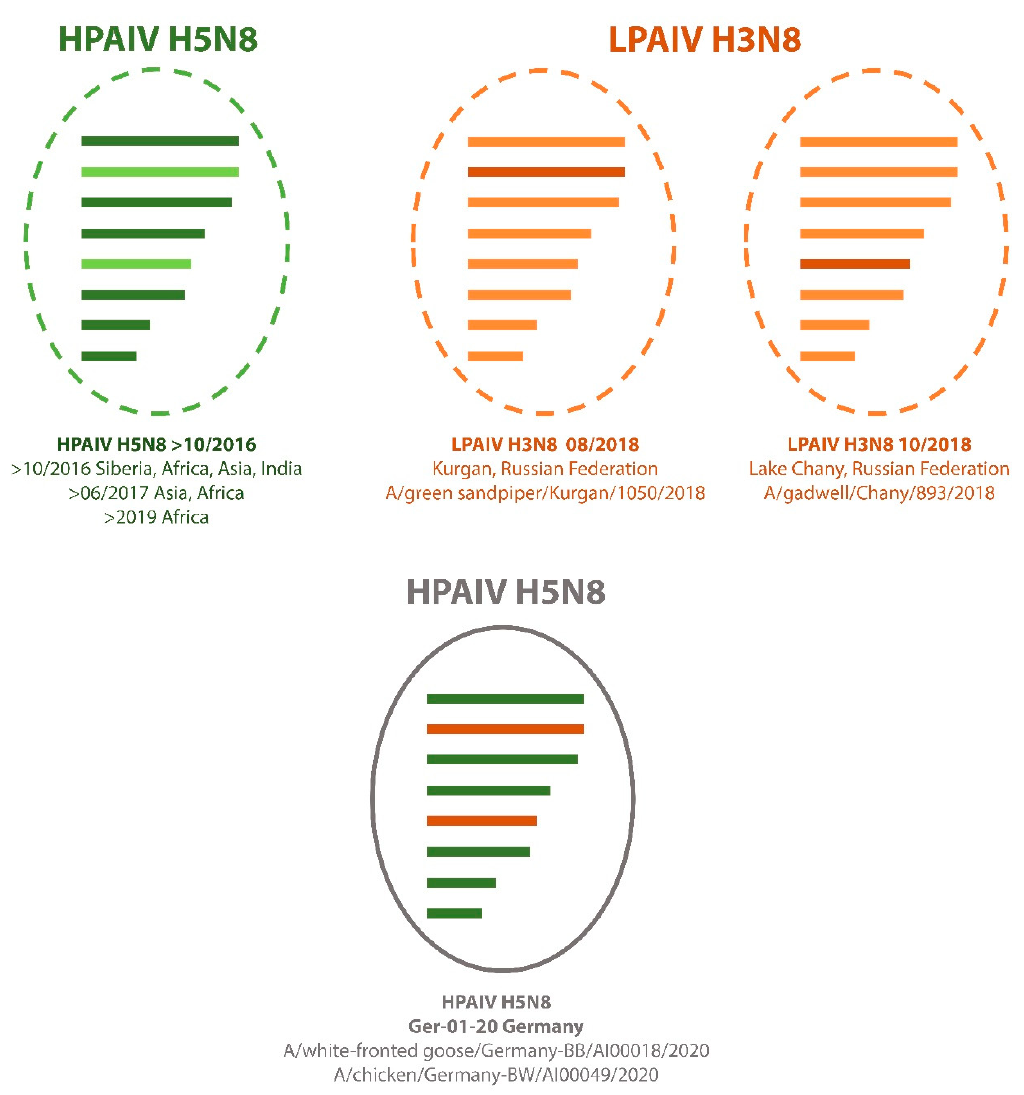
Figure 3. Schematic reassortment analyses based on full-length sequences from AIVs previously detected (upper panel) and the novel HPAIV H5N8 reassortant Ger-01-20 (lower panel). Colors are allocated according to reassortment and display the new composition of HPAIV H5N8 Ger-01-20. Overall, the phylogenetic analyses demonstrate high similarity ranging from 99.53%–100% (Table S1) between the novel HPAIV H5N8 Ger-01-20 reassortant detected in both a wild bird and poultry and newly released sequences from Poland (A/turkey/Poland/23/2019 and